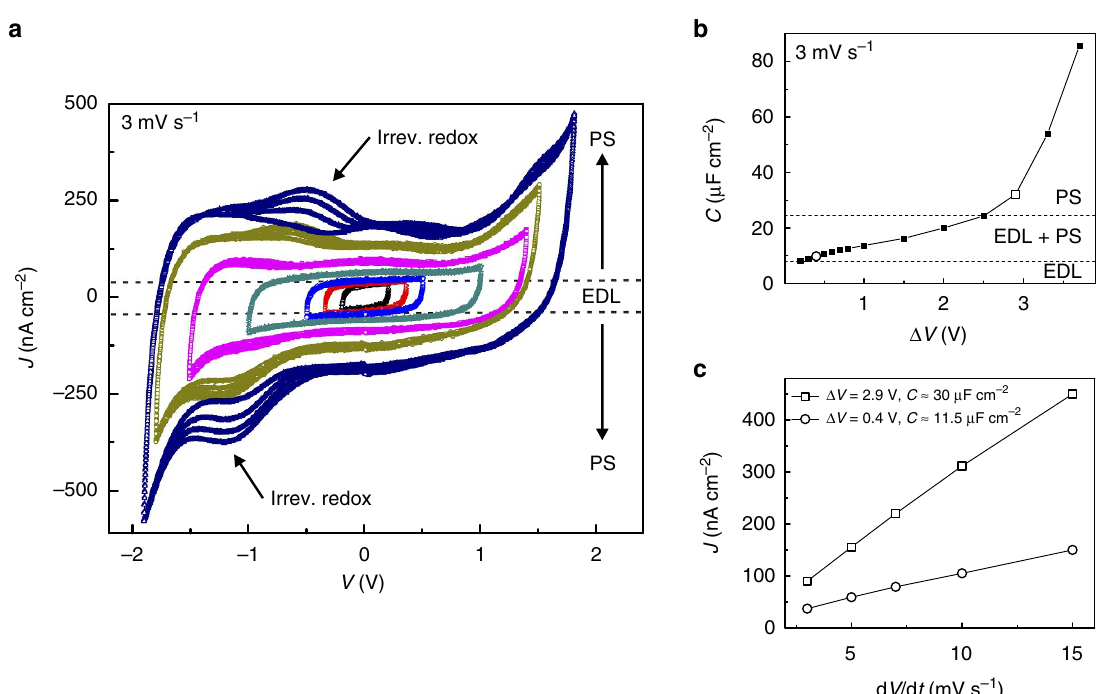
Figure 2 | Transition from capacitive to pseudocapacitive charging at 220K. ( a ) Current density—voltage characteristics upon expansion of the potential window (0.2V o D V o 3.7V) using a scan rate of 3mVs (cid:2) 1 . Each curve corresponds to four consecutive CV cycles. The dashed lines qualitatively delimit the operative region expected for an ideal EDL capacitor. The increment in current density on increasing the applied D V indicates a progressive PS behaviour. The arrows indicate the points where irreversible redox reactions start to appear. ( b ) Calculated capacitance versus applied voltage for a scan rate of 3mVs (cid:2) 1 . The trend of C indicates a gradual transition from EDL capacitance to PS up to D V (cid:3) 2 : 4V. Beyond this value, the steep increase in C denotes the predominance of PS. ( c ) Voltage ramp rate dependence of the current density for a particular potential window of 0.4 and 2.9V. In b , c , the experimental errors are within a 5% accuracy.